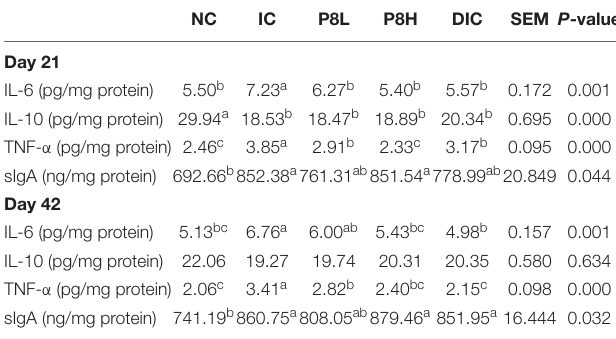
TABLE 7 | Effects of P8 on the immune indices in jejunum mucosa of Eimeria -infected broilers at days 21 and 42.